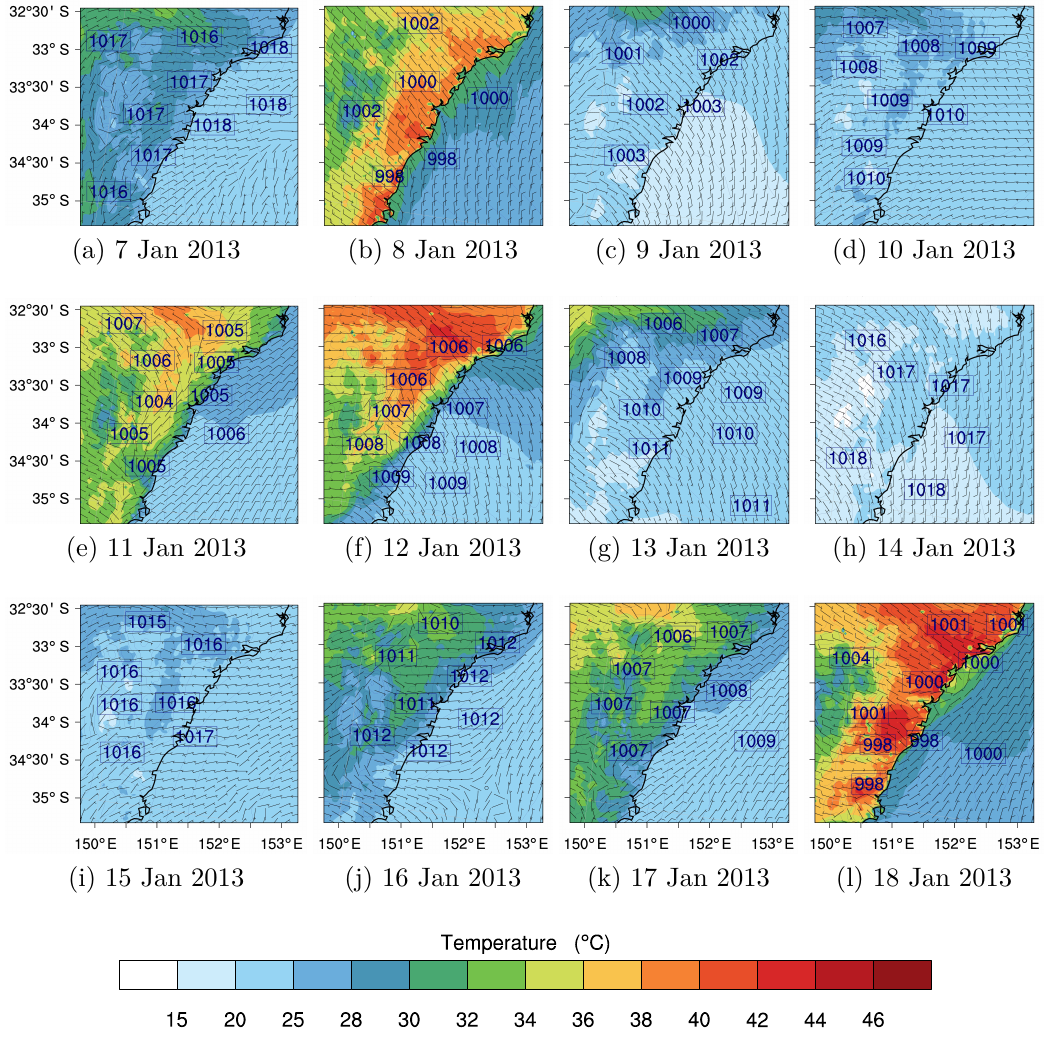
Figure 3. Simulated temperature and sea-level pressure (hPa) from 7 January to 18 January 2013 at 3:00 p.m. local